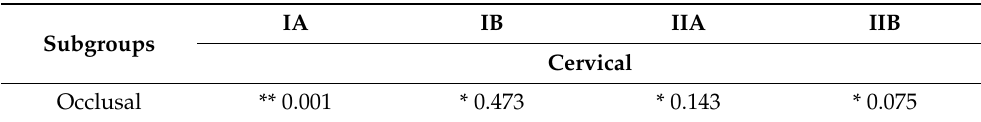
Table 4. Statistical differences between the values obtained at cervical and occlusal margins in each